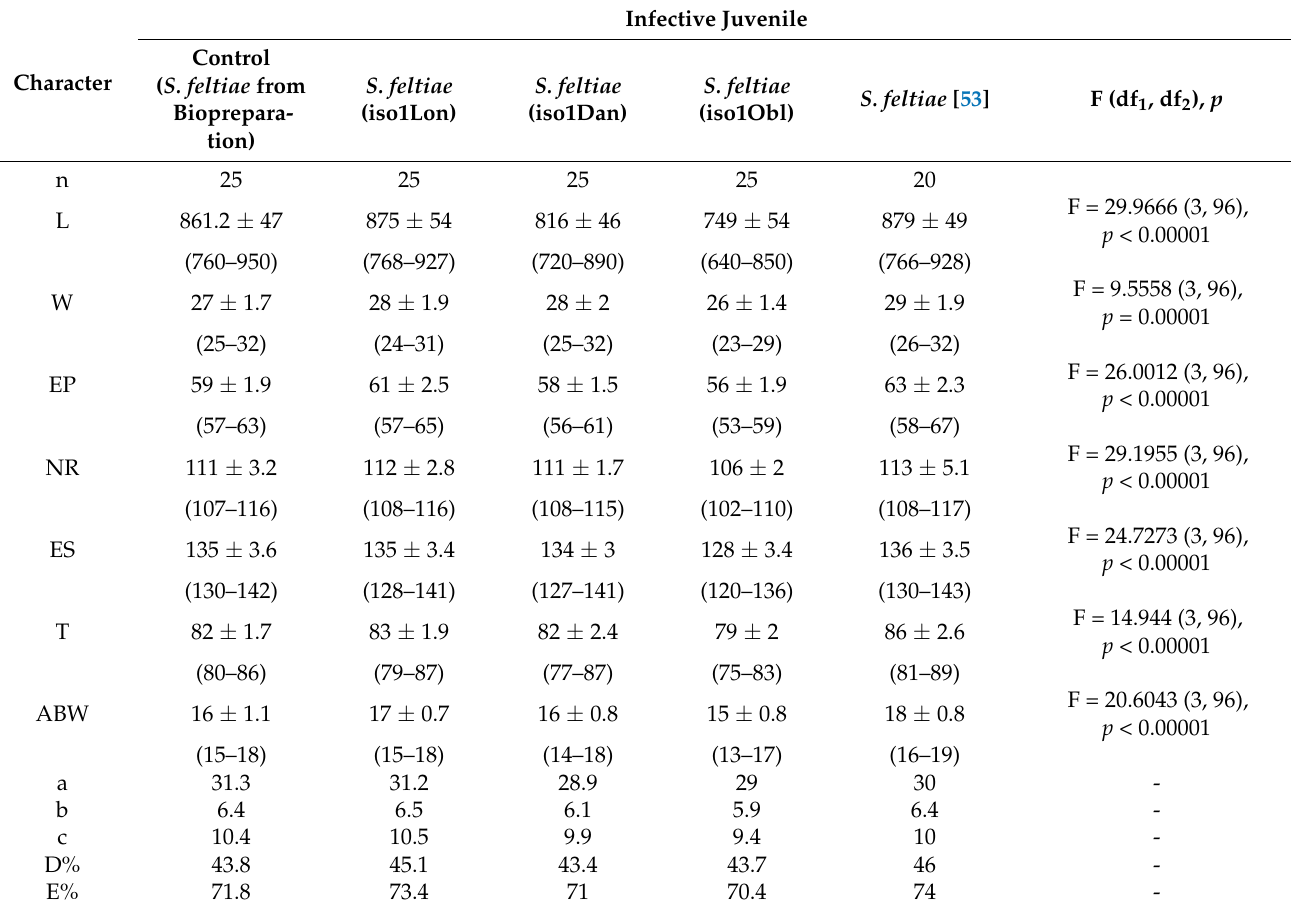
Table 1. Morphometric variables (mean ± SD) of infective juveniles of Steinernema feltiae from Poland. Variables (in µ m) are analyzed by one-way ANOVA with correspondent F statistic, with degrees of freedom (df) and p